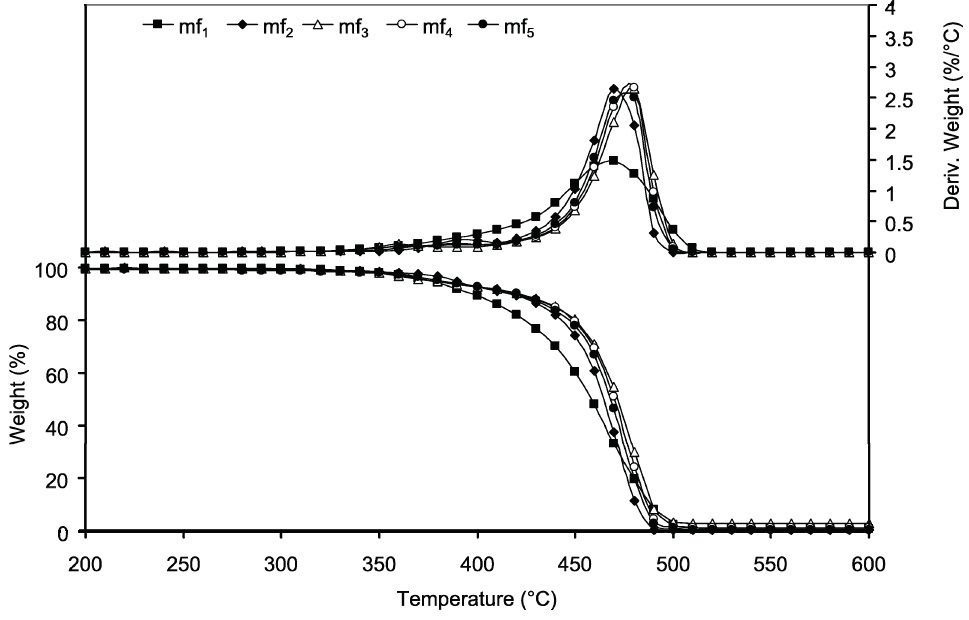
Figure 3. TG and DTG curves of loaded iPP fibers in inert atmosphere with a heating rate of 10 °C·min − 1 .